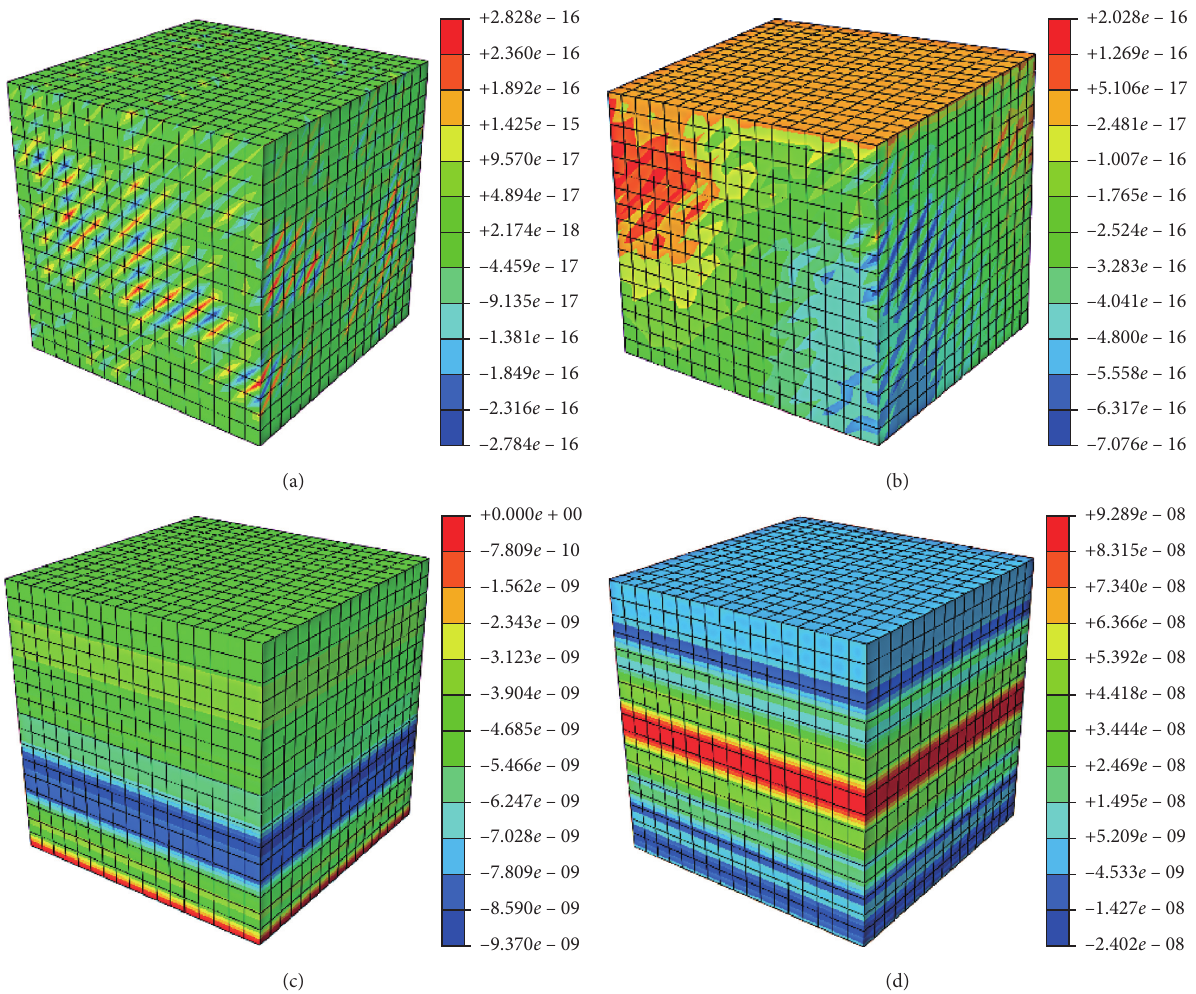
Figure 3: Vertical deformation results for model 1 (unit: m). (a) Method A, (b) method (B), (c) method C, and (d) method